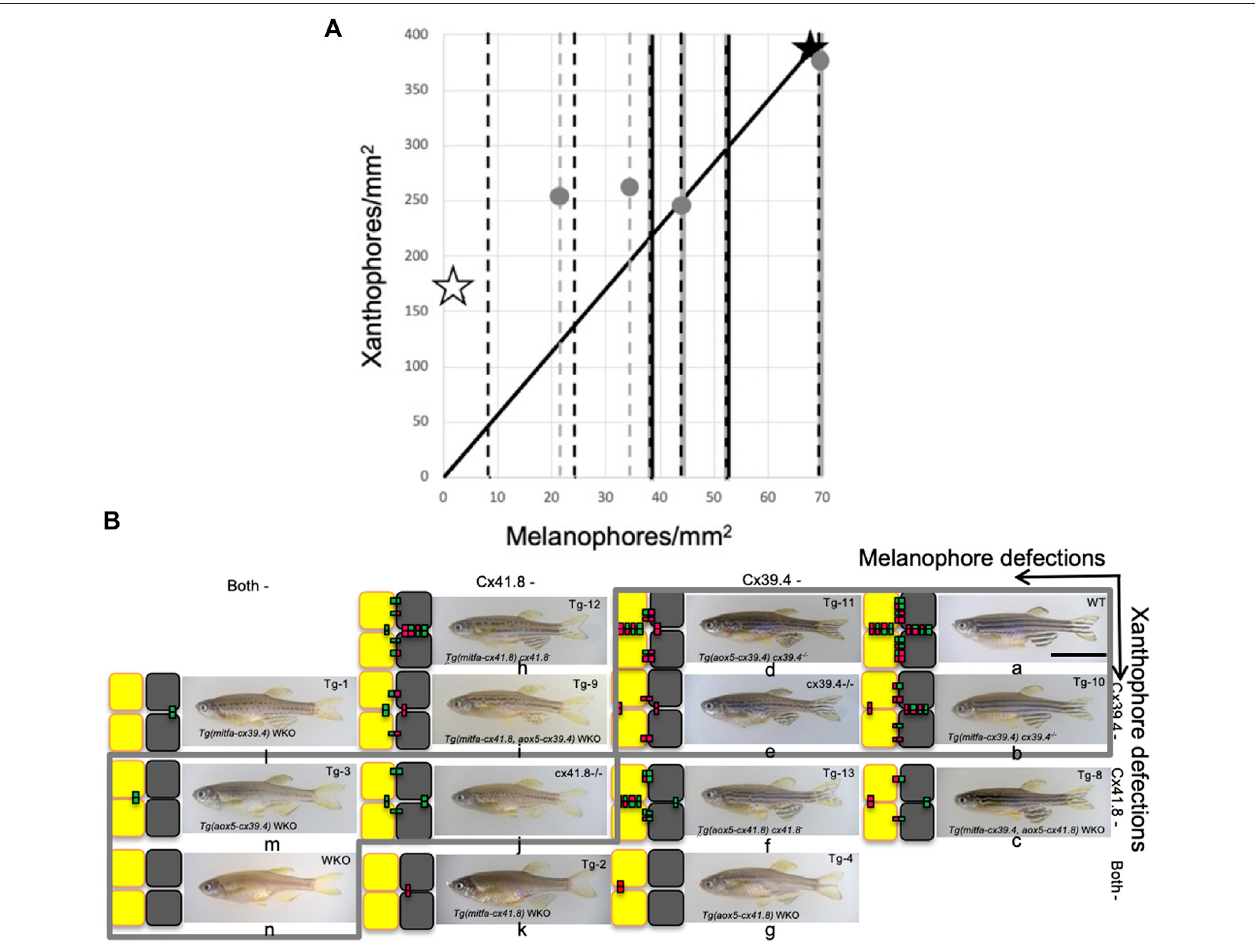
FIGURE 6 | Shuf fl e of mutant fi sh that gives accordance with numerical results. (A) A scatterplot of two types of pigment cells. Stars and dots indicate shifts of proportion of pigment cells caused by experimental manipulations of connexin by [8]. However, most data can be obtained only about melanophores, so changes in melanophorenumberareindicatedbybrokenlines.Simplebrokenlinesindicatetheadditionofconnexinstodoubleknockout(WKO);blackonesare “ onmelanophore, ” and gray ones are “ on xanthophore, ” and broken lines with solid lines on the back denote deletion of connexon from WT; black dot on gray corresponds to “ from melanophore ” and gray dot on black “ from xanthophore. ” Solid lines indicate the proportion of WT. Open stars and fi lled ones indicate the values of WKO and WT, respectively. (B) Mutant fi sh are shuf fl ed for accordance with numerical results in Figure 3I . Each small letter indicates the corresponding fi sh with simulation in the aspect of pattern selection.